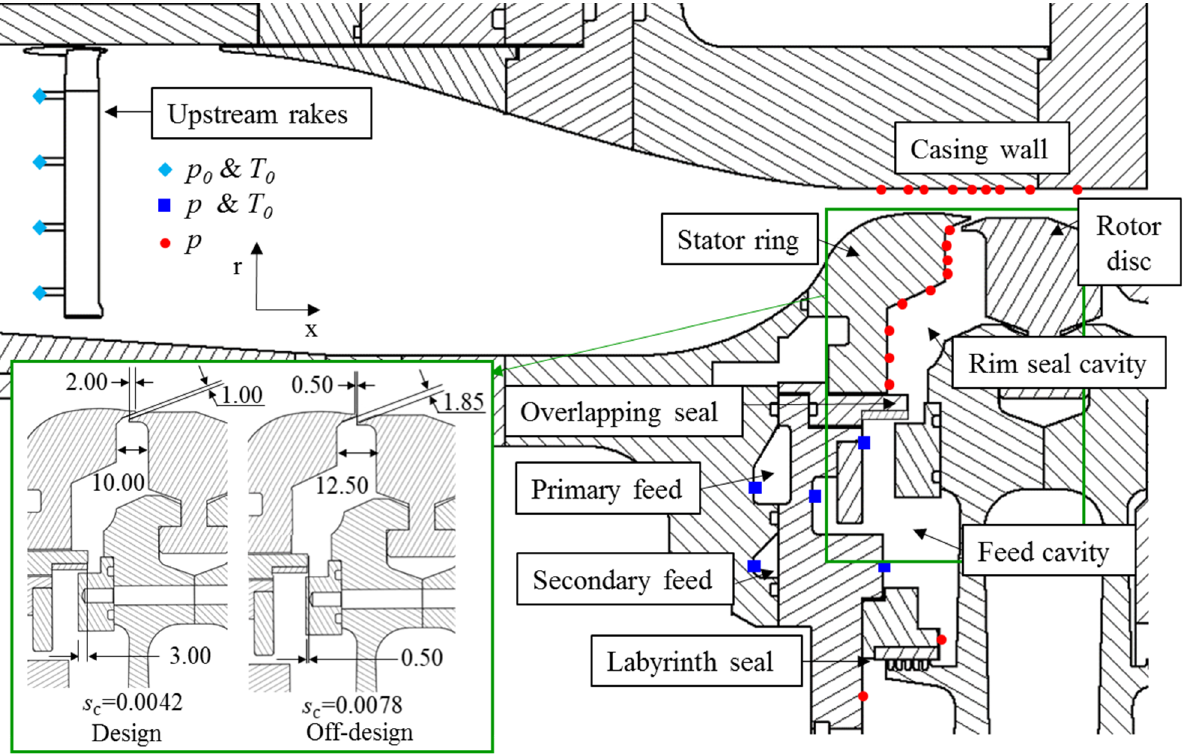
Figure 2. Longitudinal cross section of the facility with instrumentation.